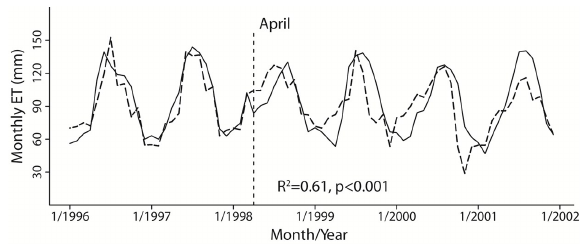
Fig. 4. Comparison between LH-simulated (black line) to observed (dashed line) monthly ET (German, 2000) during the years 1996– 2001 in Florida Everglades